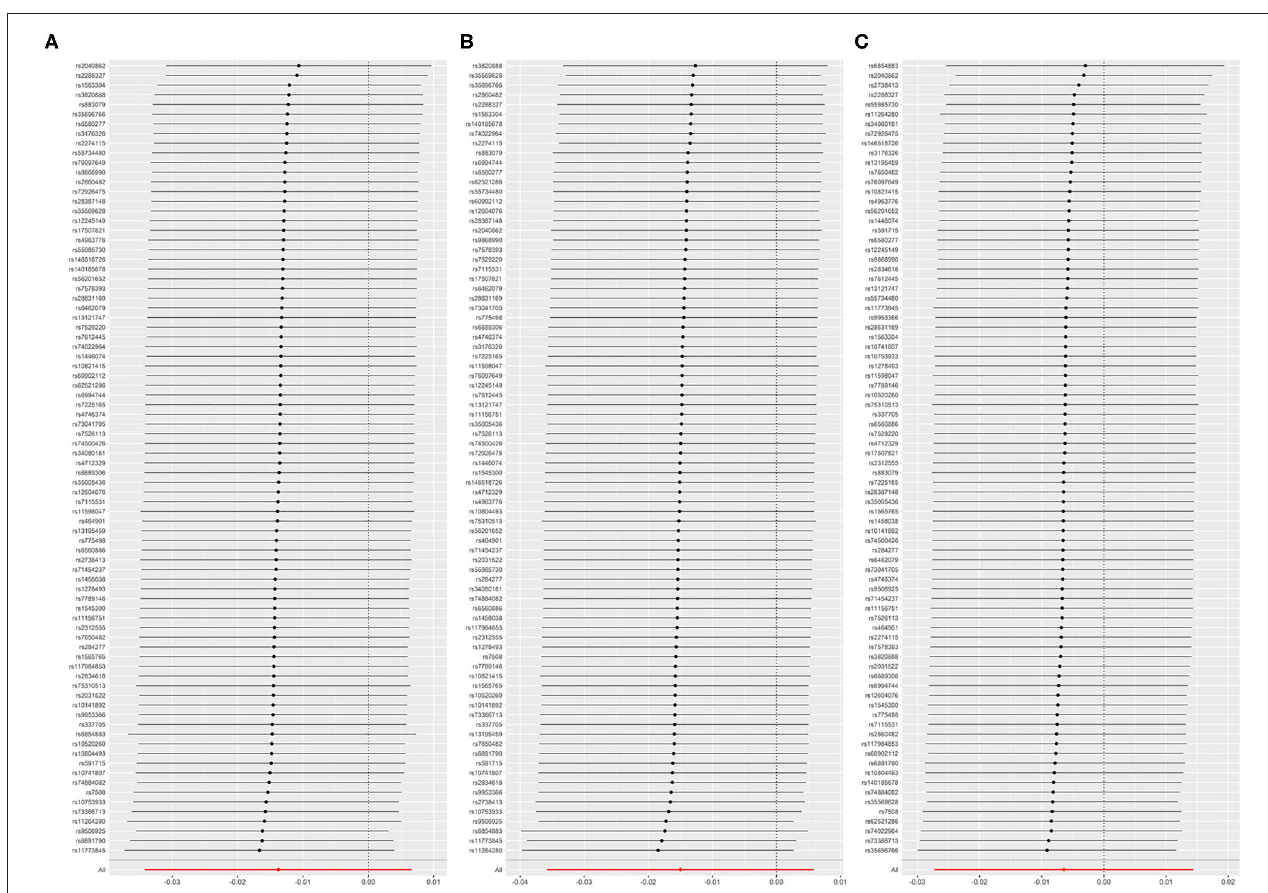
FIGURE 4 | (A) Leave-one-out plot: MR sensitivity analysis for AF on FEV1. (B) Leave-one-out plot: MR sensitivity analysis for AF on FVC. (C) Leave-one-out plot: MR sensitivity analysis for AF on FEV1/FVC. Each row is interpreted as a Mendelian randomization analysis of the causal effects of AF on FEV1 (A) , FVC (B) , and FEV1/FVC (C) using the remaining instrumental variables other than the SNP listed on the y-axis. The dots represent the odds ratio after removing the corresponding SNP, and the lines represent the corresponding 95% confidence interval. FEV1, forced expiratory volume in one second; FVC, forced vital capacity; FEV1/FVC, the ratio of FEV1 over FVC; AF, atrial fibrillation; SNP, single nucleotide polymorphism.